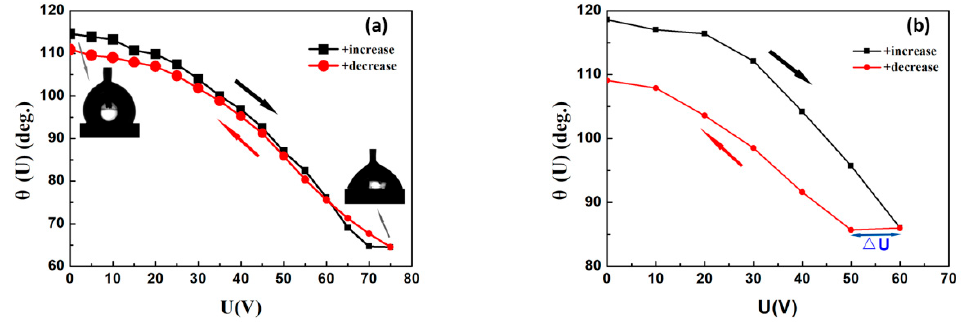
Figure 10. ( a ) Contact angle modulation for water in air on PVT/PMMA1/Teflon at AC voltages from 0–75 V; ( b ) contact angle modulation for water in air on PVT/PMMA1/Teflon at DC voltages from 0–60